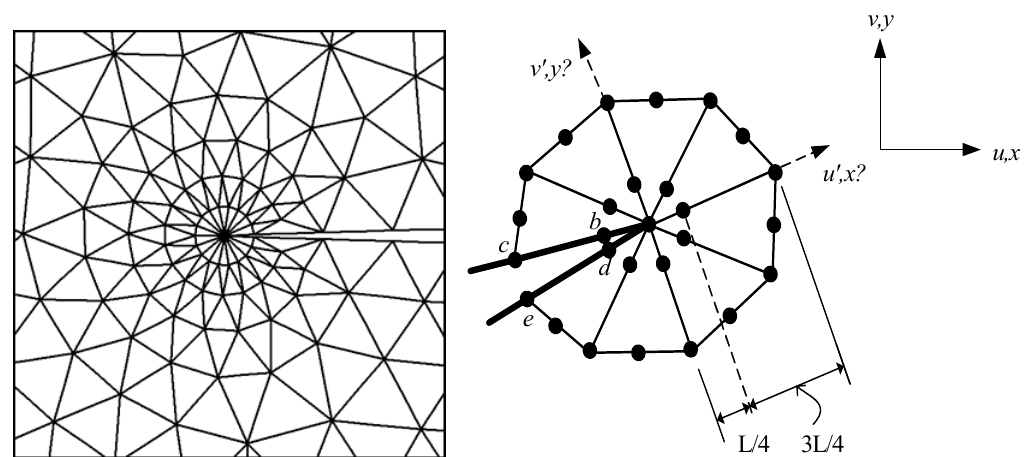
Figure 2. A quarter-point singular element around the tip of the crack.